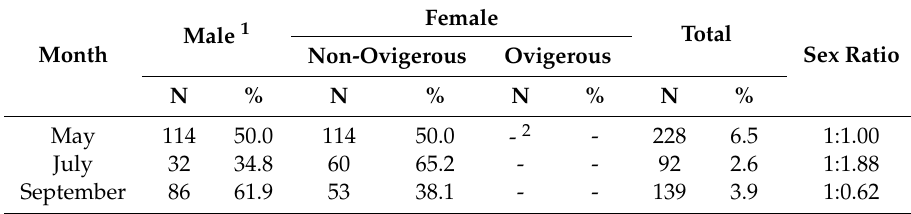
Table 1. Abundance and sex ratio of D. japonicus observed during the sampling periods.